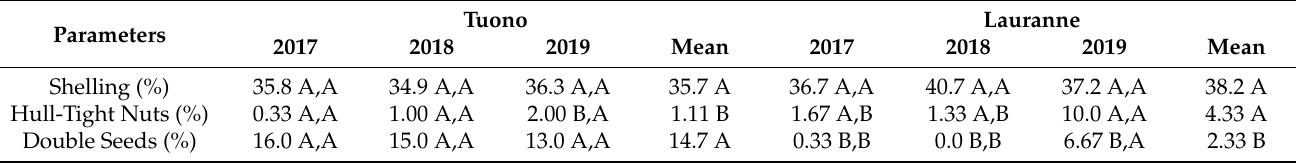
Table 3. Fruit quality parameters of cultivars Tuono and Lauranne in three subsequent years (2017–2019). The first letters denote statistical differences between cultivars for each year; the second letters denote statistical differences among different tree years for each cultivar ( p = 0.01; SNK